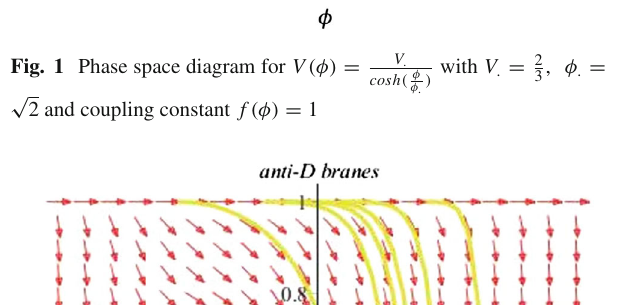
φ φ. with V . = 2 , φ . = 0 3